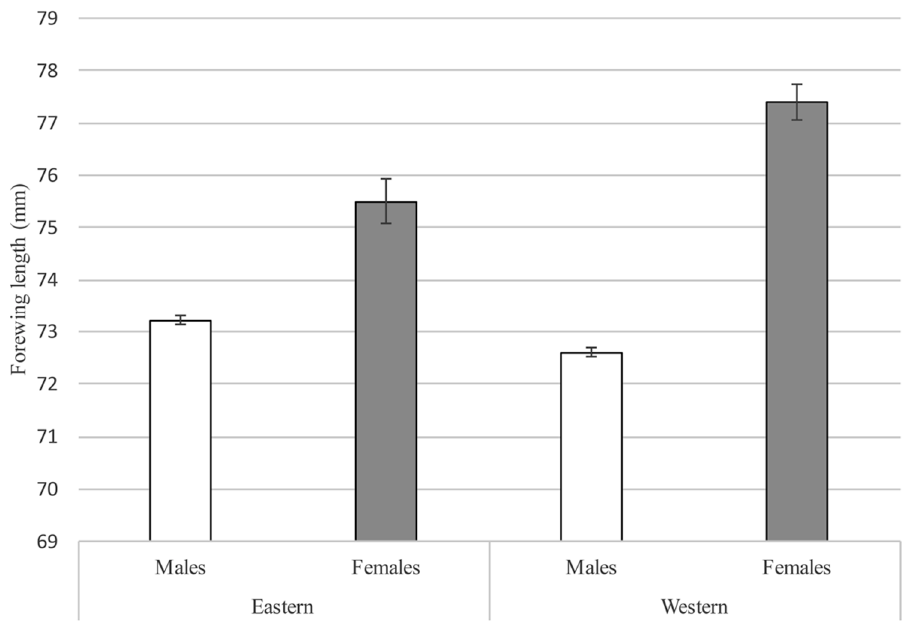
Figure 4. Forewing length measurements (mean ± SE) of Papilio homerus collected from the eastern and western populations. Females of P. homerus from the eastern population ( n = 2) had significantly larger forewing lengths than males ( n = 19) ( p = 0.03). A similar pattern is shown with P. homerus collected from the western population, where females ( n = 5) had significantly larger forewing lengths than males ( n = 15) ( p = 0.02). In general, females are significantly larger than males ( n = 8, 34, respectively; p = 0.04), similar to previous reports [4,6,7]. There were no significant differences in forewing length measurements in males or females between populations ( p ≥ 0.05). All individuals measured from the eastern population and two males from the western population were acquired from the Carnegie Museum of Natural History (Pittsburgh, PA) collection. The remaining individuals measured from the western population are reported by Lehnert (2008). A two-sample unequal variance t-test was used to test for significant differences ( p < 0.05). Although no significant differences were found within sexes between populations, we suggest a future and more rigorous morphometric analysis is needed to compare populations, which would include a larger sample size, additional wing measurements, and details about the genitalia.